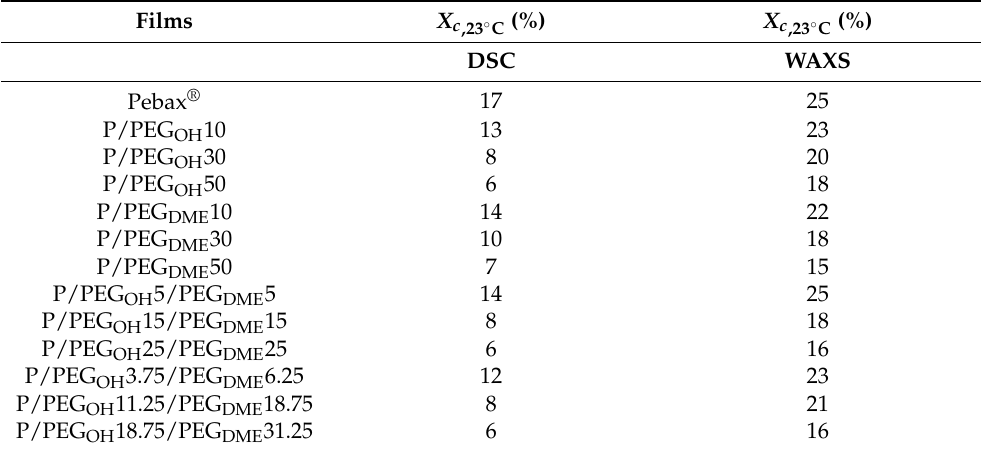
Table 1. Comparison of the crystallinity degree at 23 ◦ C determined by DSC and WAXS analysis (the standard deviation on Xc values is greater than